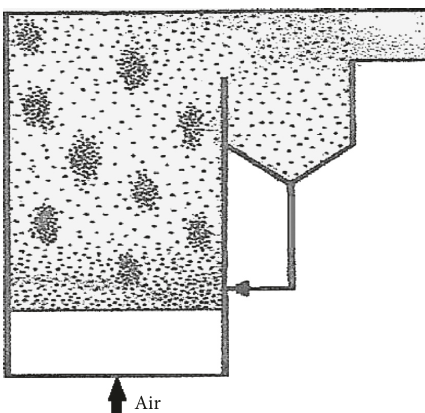
Figure 1: A fluidised bed boiler with a circulating layer.